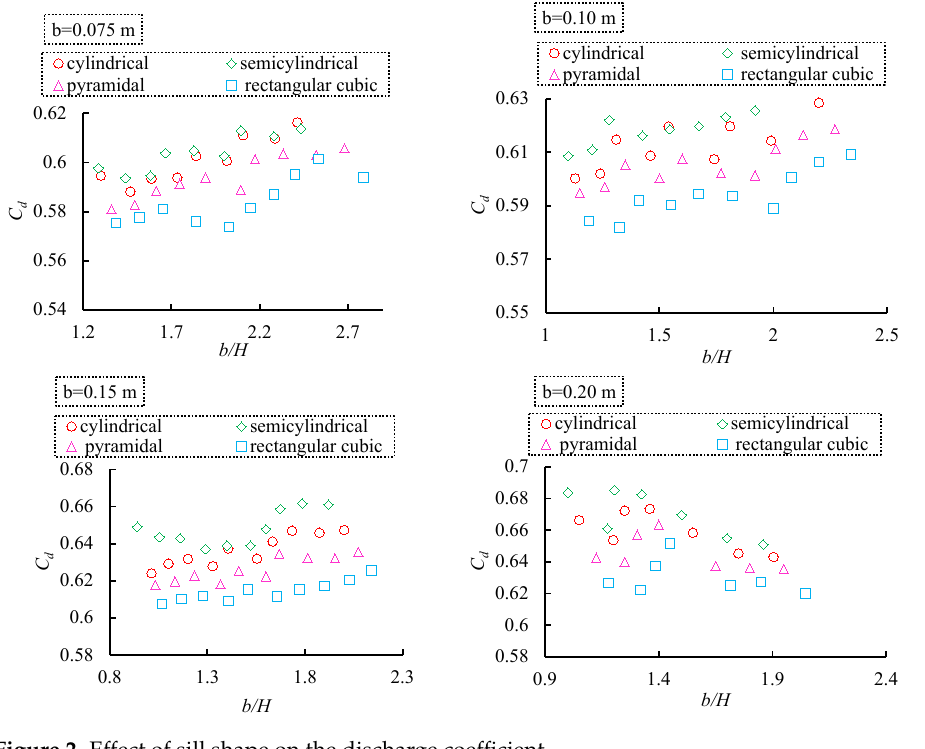
Figure 2. Effect of sill shape on the discharge coefficient.